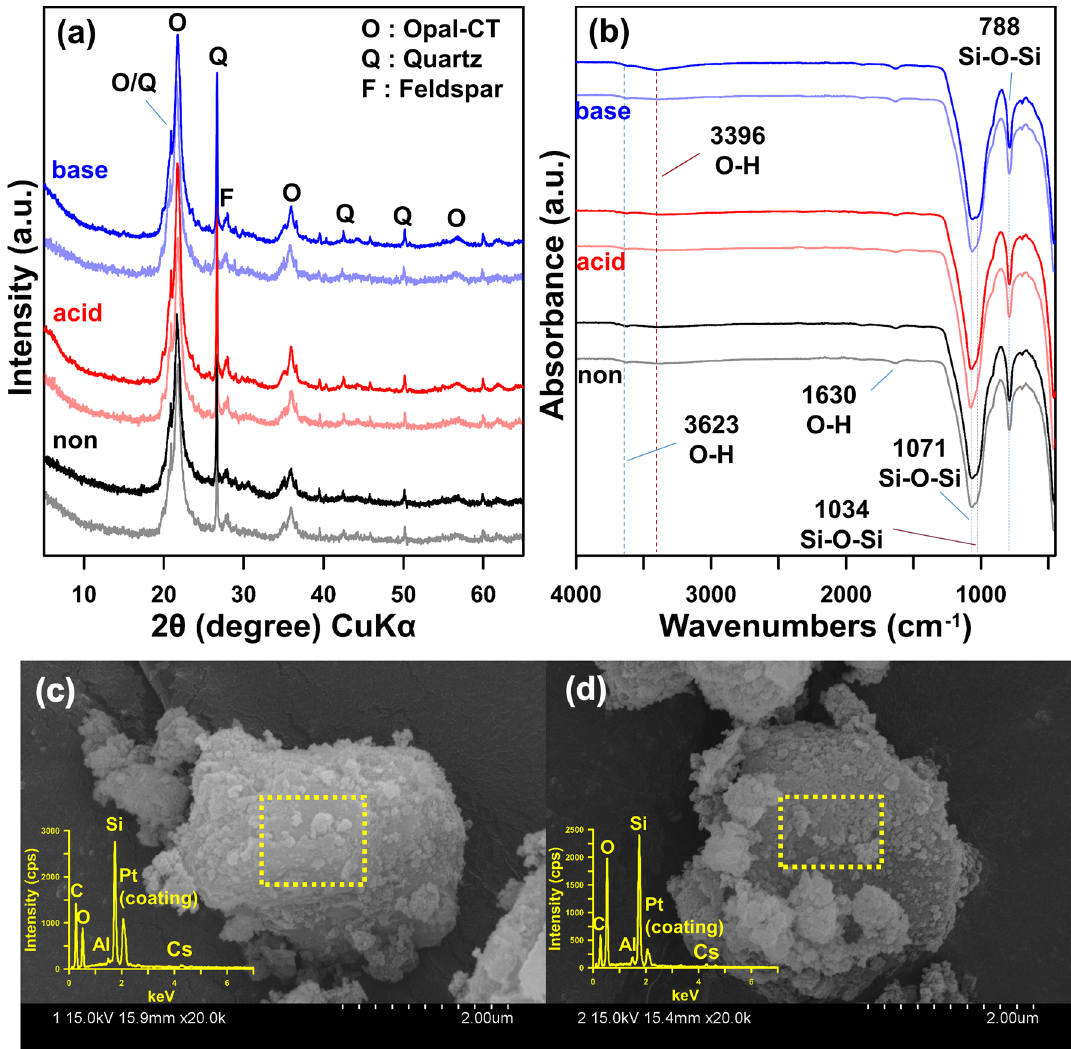
Figure 2. ( a ) XRD and ( b ) FT-IR analyses of all OMs, before (light) and after Cs adsorption (bold); and SEM– EDS analyses of the ( c ) acid-activated, and ( d ) base-activated, opaline mudstones after Cs